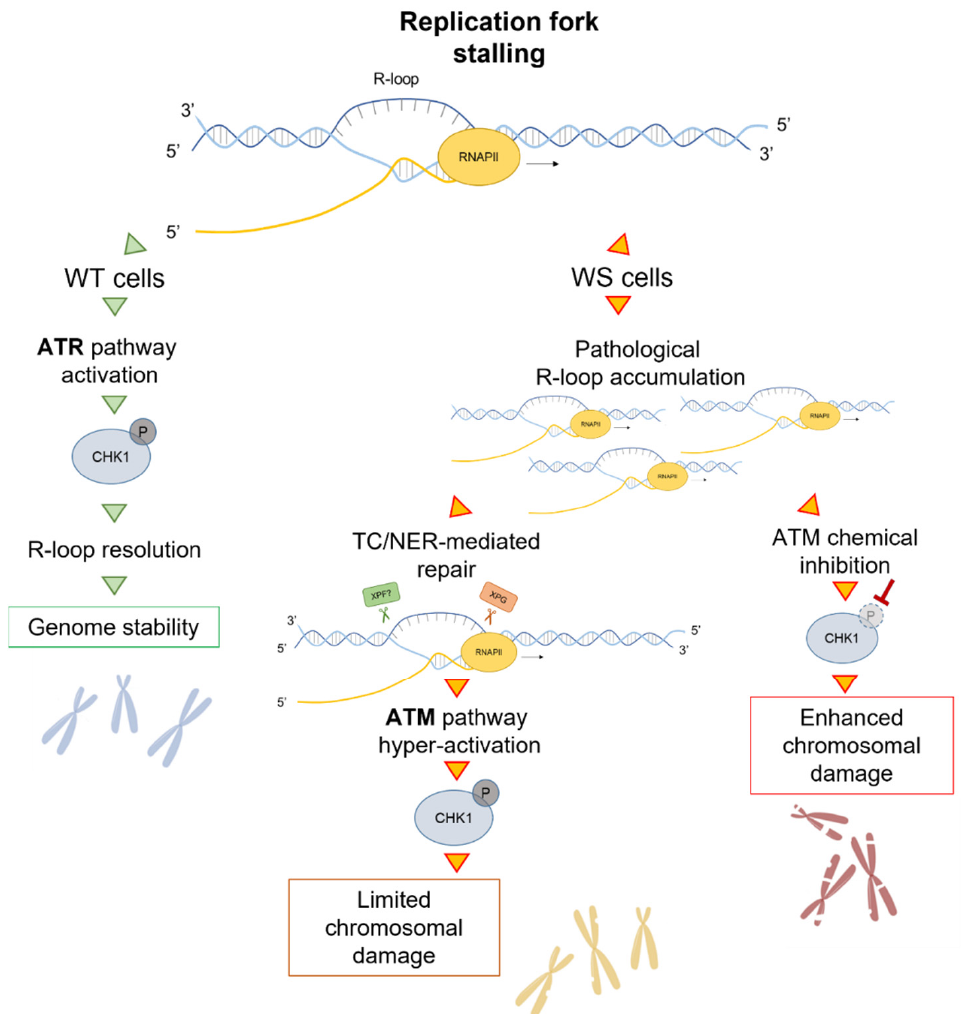
Figure 3. Model for a role of the ATM pathway in limiting genome instability in WS cells. After replication fork stalling, the presence of WRN leads to a proper ATR-dependent CHK1 activation that ensures R-loop resolution and thus genome stability. In WS cells, although an aberrant accumulation of R-loops is detected, a direct processing of these structures by the endonuclease XPG induces transient DSB formation, leading to ATM pathway hyper-activation. Under these conditions, ATM phosphorylates CHK1 and, thereby, counteracts chromosomal damage accumulation. Notably, if ATM kinase is chemically inhibited, the failure to respond to R-loop-associated DNA damage increases chromosomal damage, which is already elevated in WS cells.